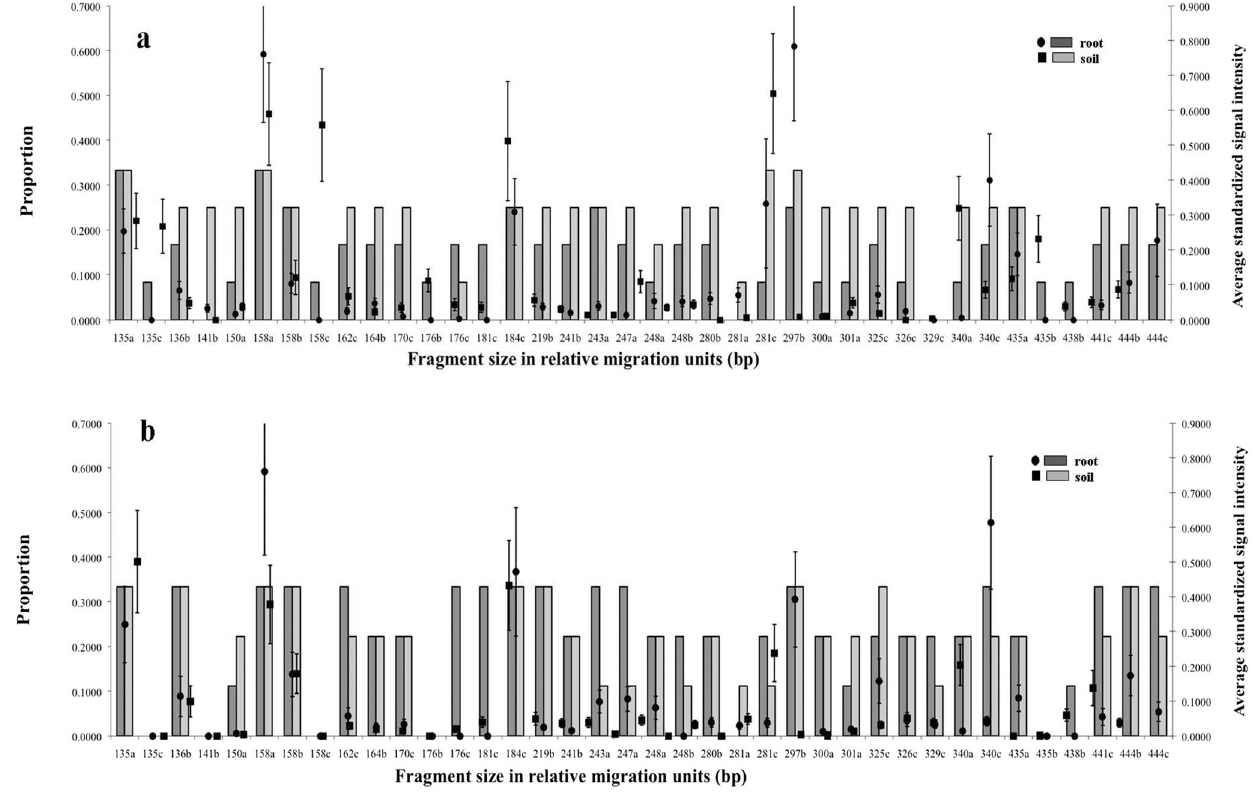
Figure 3. Occurrence of TRFs from roots and soils in (a) Tectonagrandis and (b) Aquilariacrassna . Bars indicate the proportion of samples that yielded each TRF; dots indicate the average intensity of that fragment ( 6 SEM) in those samples. The letters indicate the restriction enzyme involved in each fragment size, a: MboI , b: HinfI and c: Hsp92II .